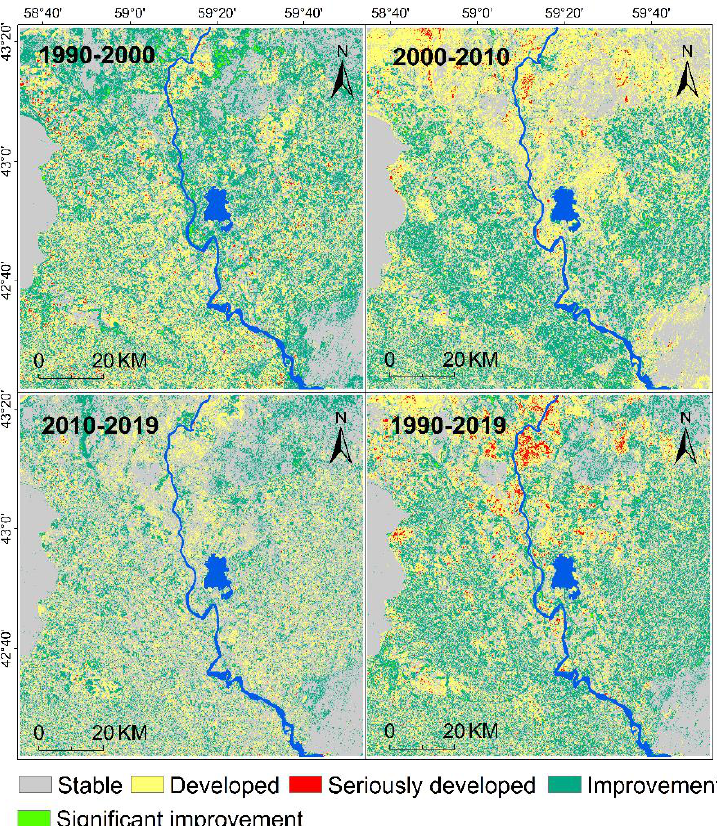
Figure 6. Spatial distribution of land degradation developed or improvement in the ADD in different time periods.